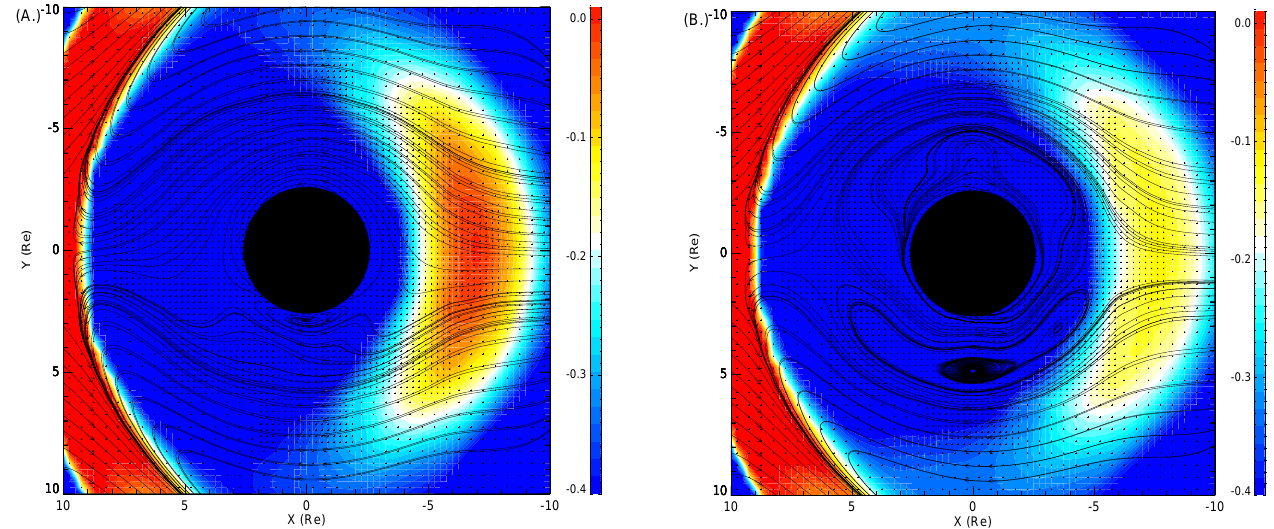
Plate 2. Color contours of the log of the pressure (in nP) in the equatorial plane of the magnetosphere, with stream traces of the in-plane velocity overplotted. (A) shows the 1mho simulation results while (B) shows the 100mho simulation results.